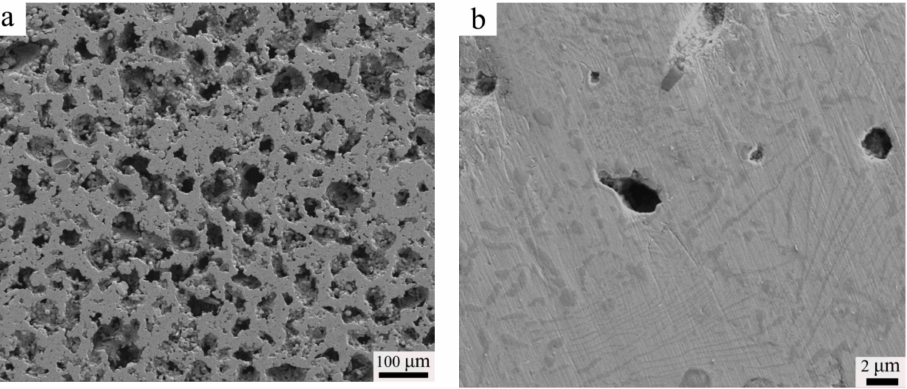
Figure 3. SEM-SE images of the as-sintered alloy A 1 ( a ) low magnification; ( b ) high